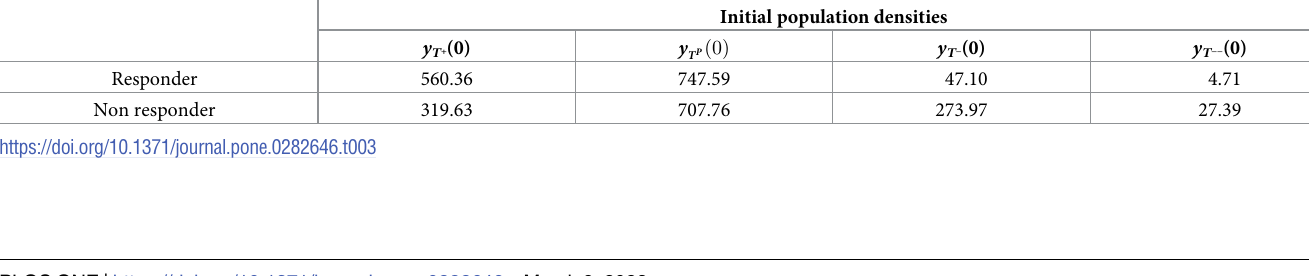
Abiraterone therapy with 50% PSA criterion on triple groups, [14, 23] which used Abiraterone therapy without considering the 50% PSA criterion on triple groups, and [24] which used a combination of Abiraterone and Docetaxel only on the best responder group. Table 2 provides the entries of the competition matrices and Table 3 gives the initial values of each subpopula- tion. As indicated in Table 3, the initial subpopulation of phenotype T −− is estimated to com- prise 10% of the initial population of phenotype T − .